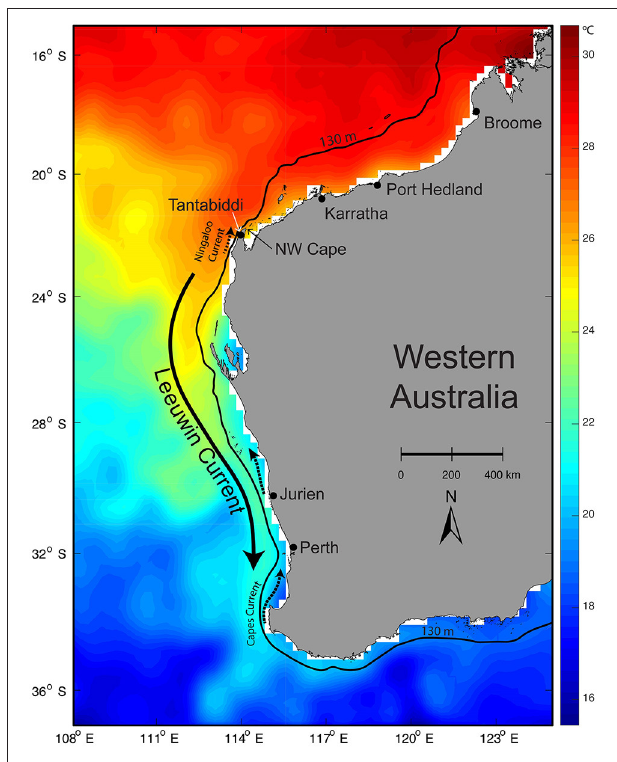
FIGURE 1 | Map of Western Australia showing particle release sites/potential release sites of rehabilitated turtles along the Western Australian coast. Dominant coastal currents are indicated with arrows overlaying NOAA OIv2 sea surface temperature for 17 March, 2010 and 130m depth contour is shown to indicate the continental shelf